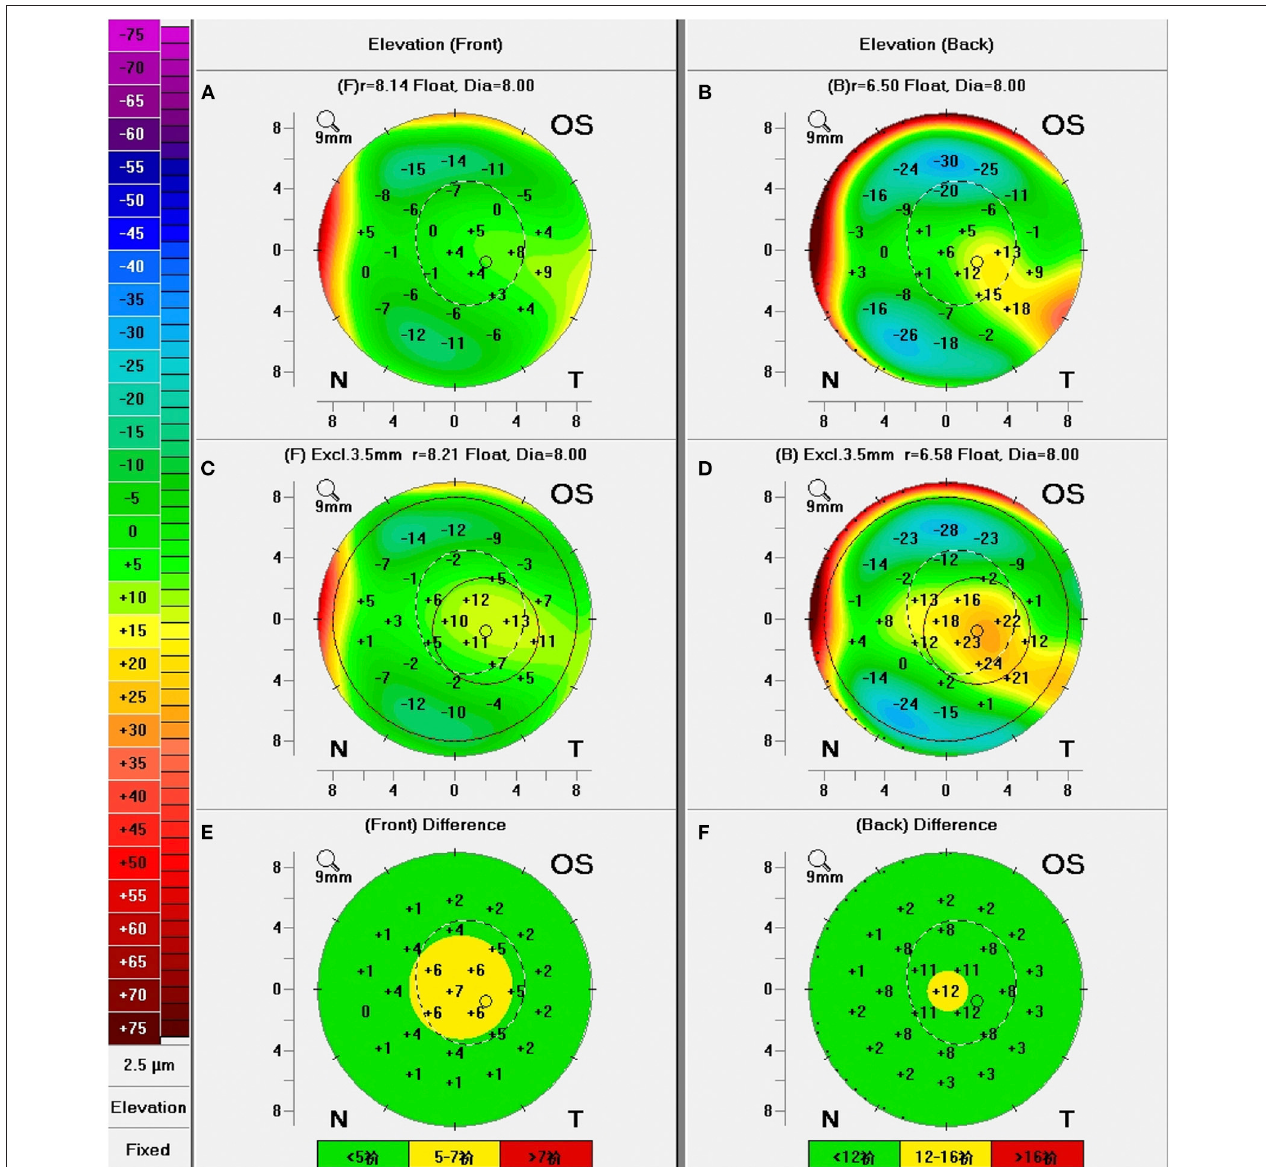
FIGURE 1 | A representative example of elevation maps in patients with allergic conjunctivitis measured by Pentacam. (A,B) Anterior and posterior corneal elevations correlated to the standard best-fit sphere (BFS) reference surfaces; (C,D) Anterior and posterior corneal elevations correlated to the enhanced BFS reference surfaces (with exclusion of a 3.5-mm optical zone in the thinnest portion of the cornea); (E,F) Anterior and posterior corneal elevation differences between the elevation values correlated to the standard BFS and the enhanced